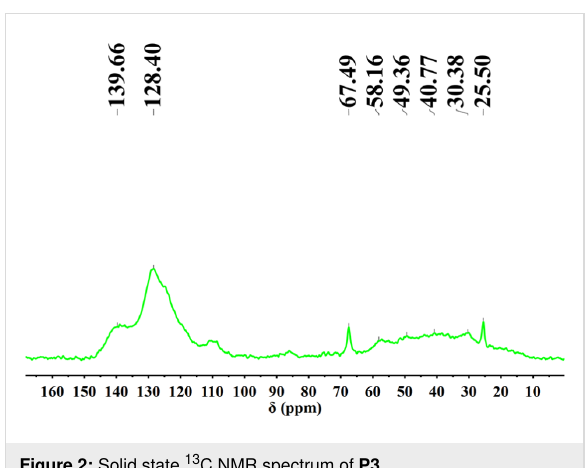
Figure 2: Solid state 13 C NMR spectrum of P3 .